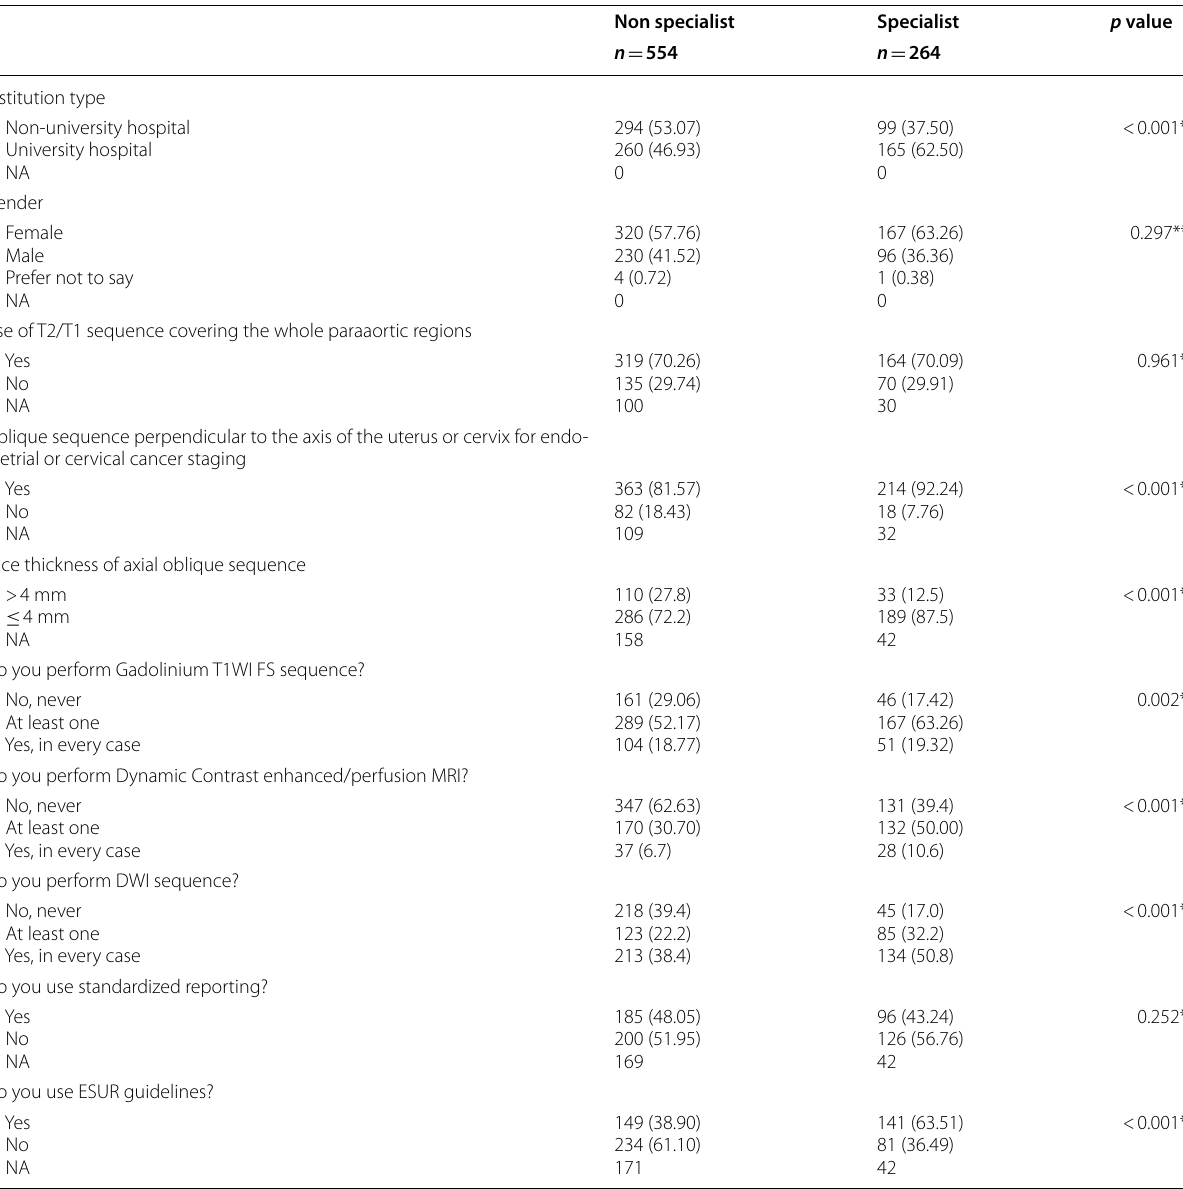
Table 2 Subgroup analysis regarding expertise in gynecological